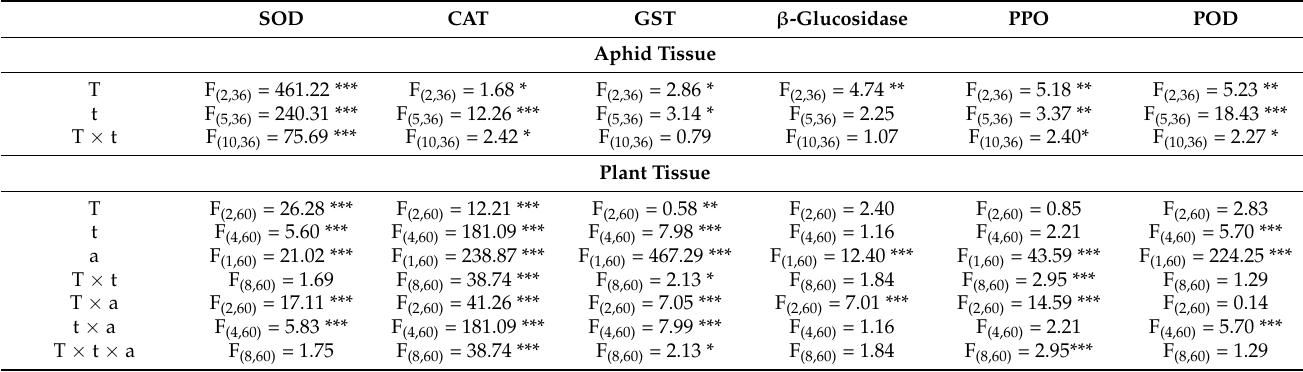
Table 2. Analysis of enzymatic activity in the tissues of aphid Macrosiphum rosae and plant Rosa rugosa . ANOVA was used to test differences between average enzymatic activity in different conditions ( p < 0.05). (T, temperature; t, time; a, aphids). SOD GST